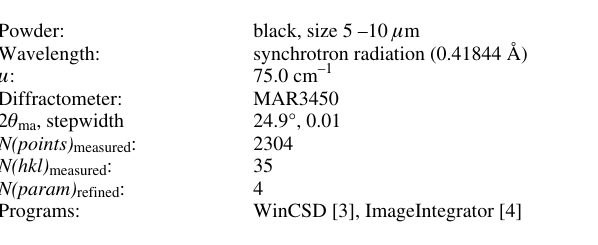
Table 1. Data collection and